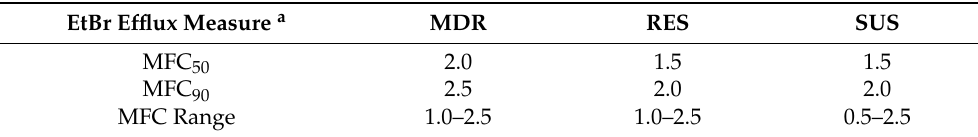
Table 5. Expression of efflux mechanisms ( µ g/mL) in terms of bacterial ability to pump ethidium bromide (EtBr) out of the cell and do not emit fluorescence when under UV lighting among mesophilic aerobe and facultatively anaerobic Gram-negative rods presumptively characterized as enterobacteria isolated from meat and fish